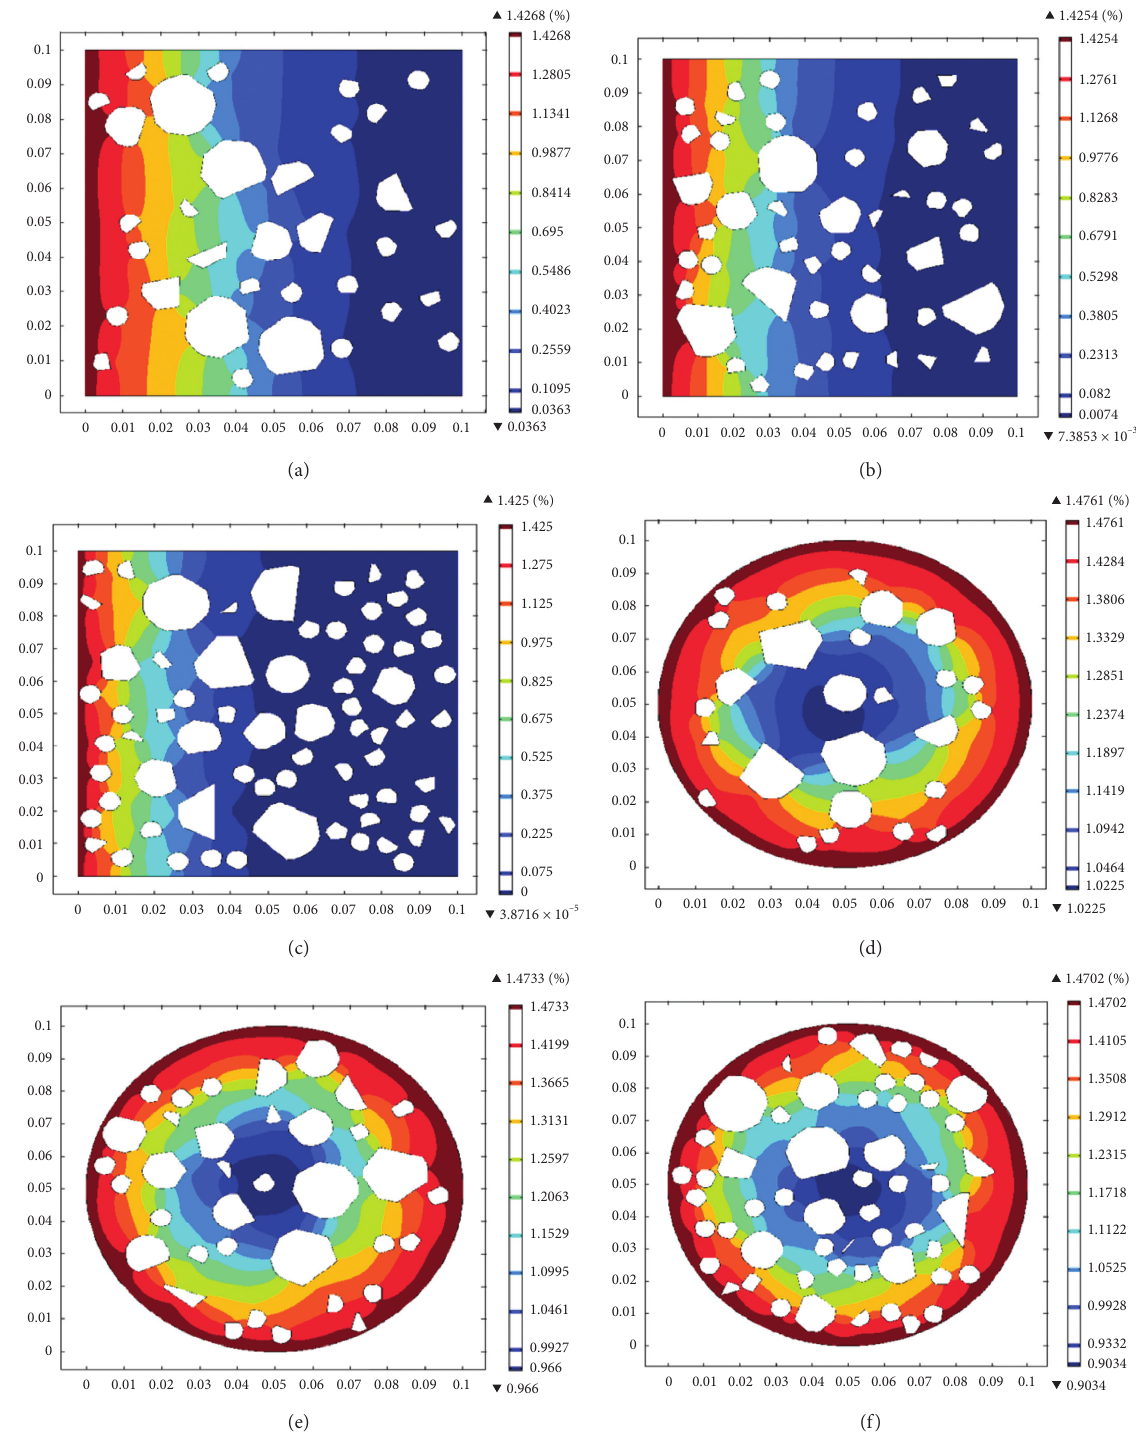
Figure 7: Distribution of chloride concentration at t � 5 years and t � 15 years. (a) f 75%, t � 15 years. (d) f a � 35%, t � 5 years. (e) f a � 50%, t � 5 years. (f) f a � 75%, t � 5